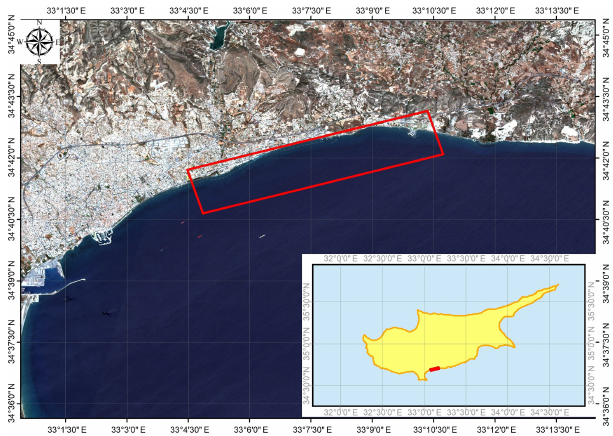
Figure 1. Location of study site in Cyprus. Figure 2. Field data acquired by the Department of Land Survey in